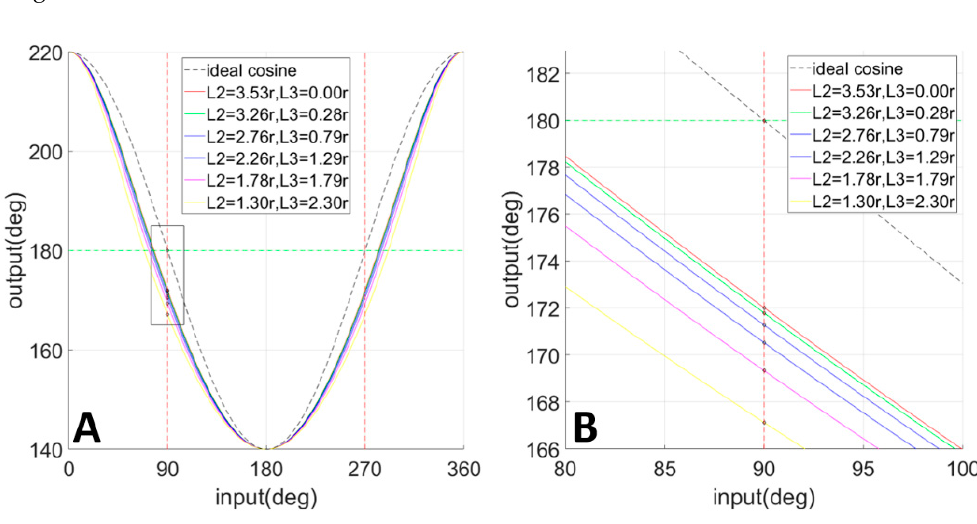
Figure 7. ( A ) Simulated output flapping angle vs. input crank angle by varying L 2 and L 3 . ( B ) The magnification of the rectangle indicated in ( A ).